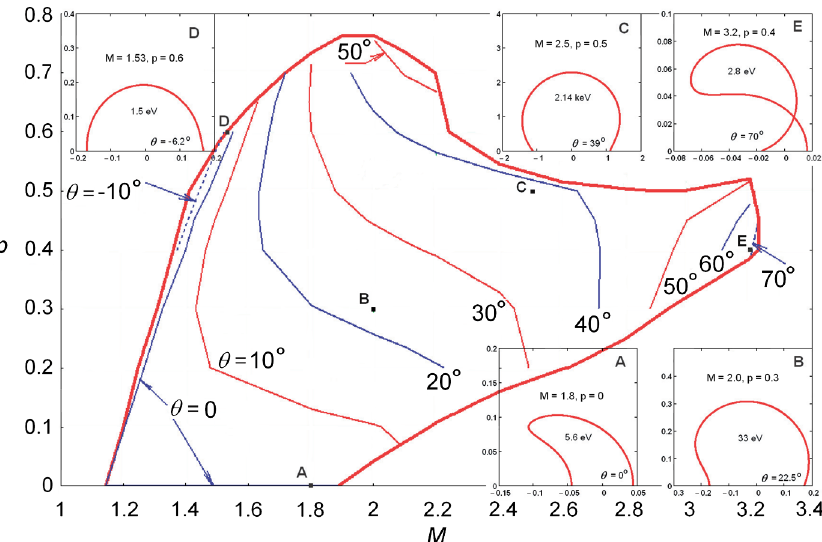
FIG. 10. Incidence angle of the impacting electrons in the first zone of the two-point multipactor. The initial velocity vector is normal to the surface. Shapes of trajectories are shown for several points in the area of stability. Dimensions of trajectories—in millimeters. Trajectories are shown in different scales but equal for both axes to show the angle.